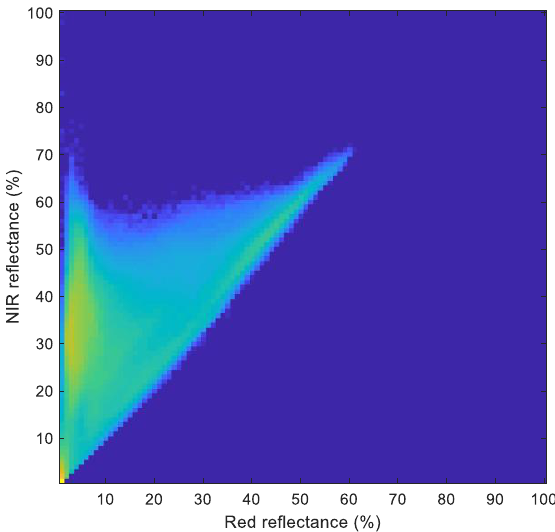
Figure 7. 2D histogram plot (log frequency) of red–NIR bands from global MODIS white-sky albedo at a maximum NDVI. The bin size is 1% reflectance in both bands.